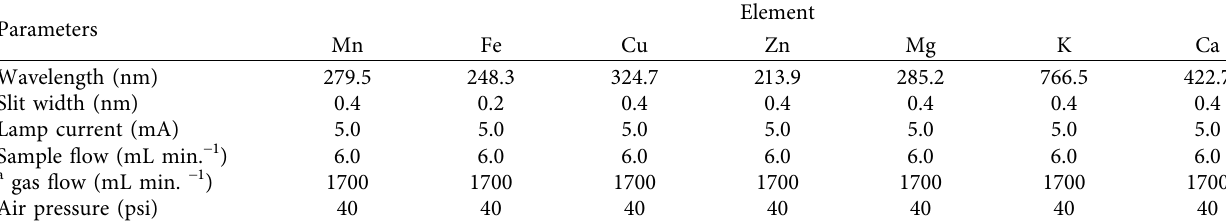
Table 2: FAAS operational parameters.